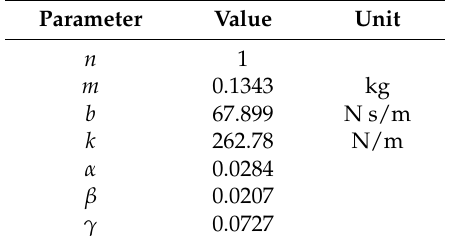
Table 1. Identified model parameters of the piezoelectric actuator (PEA) with BW hysteresis.